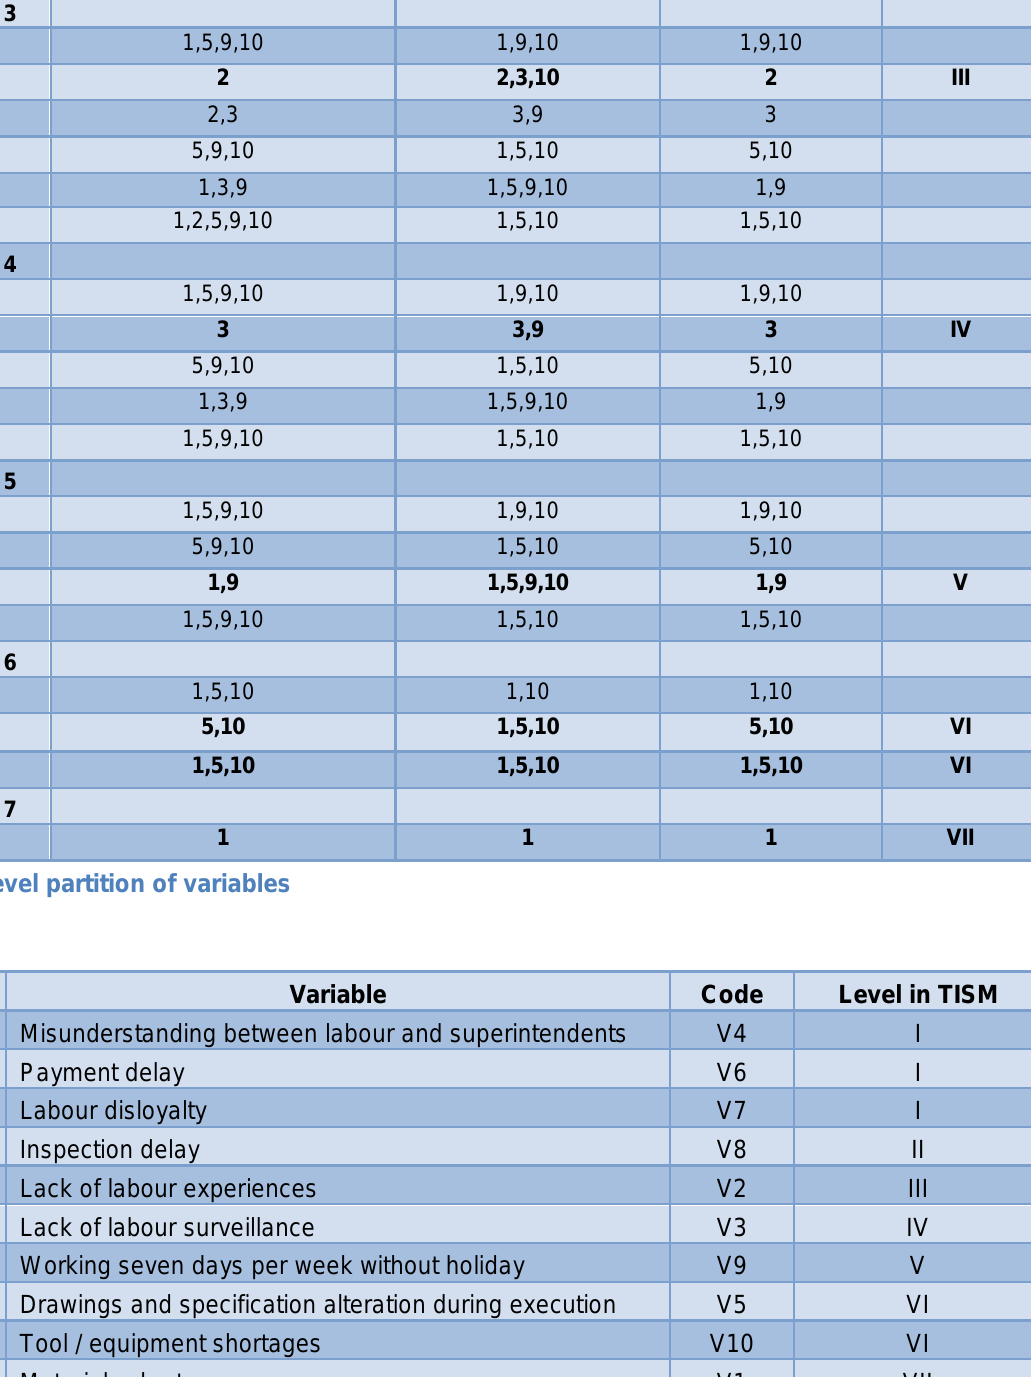
Table 5 Variable and respective